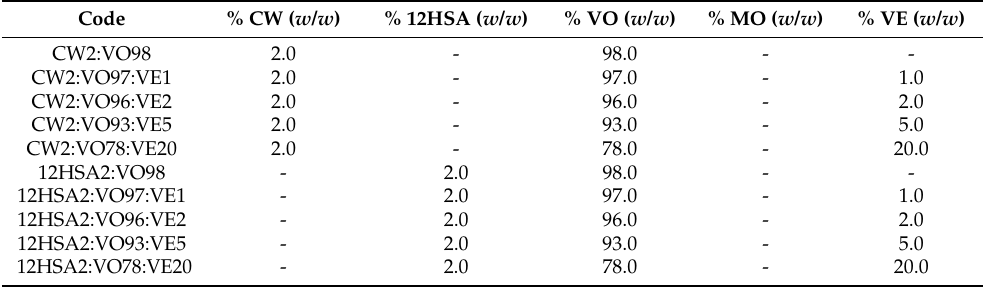
Table 2. Organogels studied in this work. The acronyms “CW”, “VO”, “12HSA”, and “VE” mean candelilla wax, vegetable (sunflower) oil, 12-hydroxystearic acid, and vitamin E,